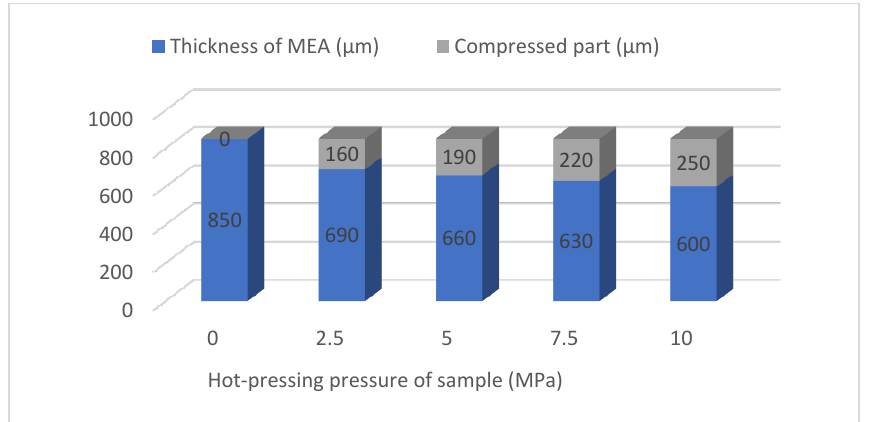
Figure 6. The influence of different forming pressure conditions on the thickness and compressibility of titanium mesh-based MEA.